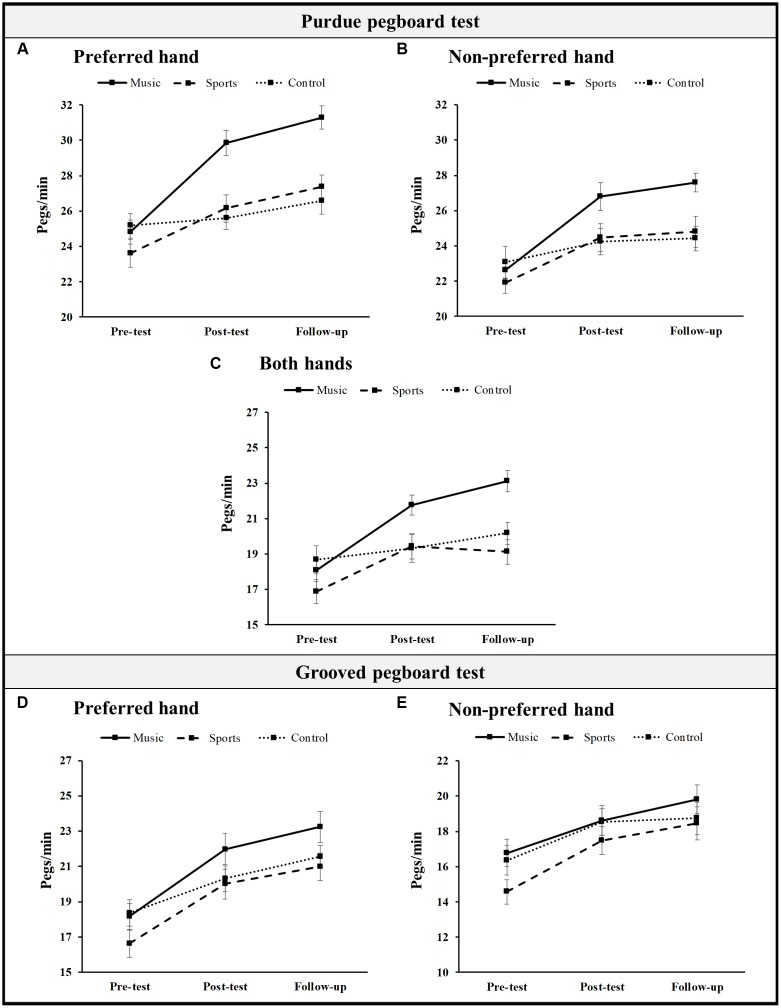
Mean scores (pegs per minute) in the Purdue Pegboard test with the preferred hand (A), non-preferred hand (B), or both hands (C), and in the Grooved pegboard test with the preferred hand (D), and non-preferred hand (E), for the music, sports, and control groups at pre-test, post-test, and follow-up. Error bars indicate SEM.